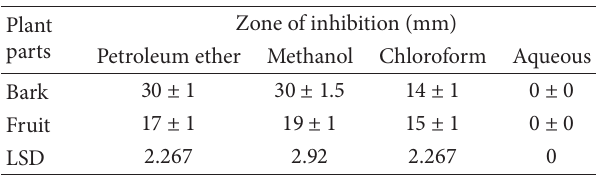
Table 4: Zone of inhibition produced by extracts of different parts